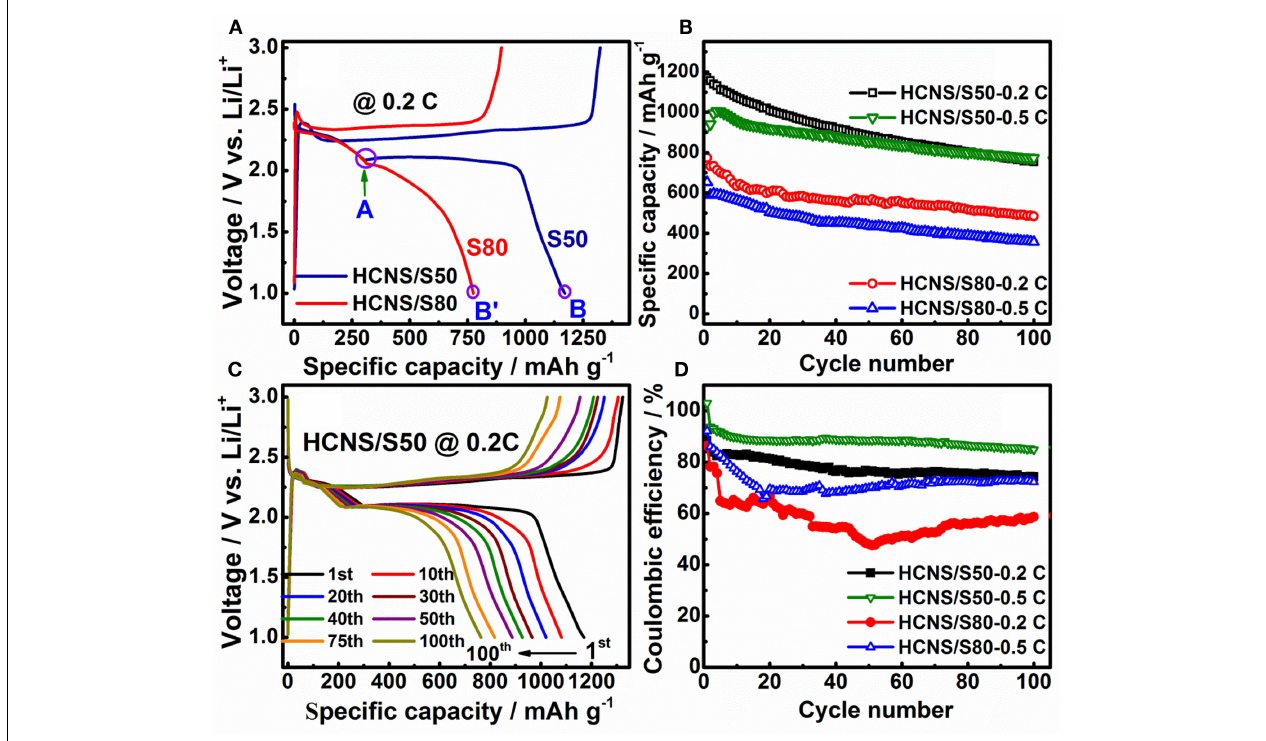
FIGURE 5 | (A) Charge/discharge profiles of HCNS/S composites at 0.2 C (336mAg (cid:0) 1 ). (B) Cycling performance of the HCNS/S composites. (C) Charge/discharge profile evolution of HCNS/S50 composite during cycling at 0.2 C. (D) Comparison of Coulombic efficiency of the HCNS/S